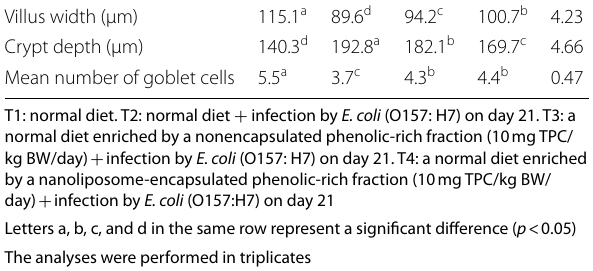
Table 6 The gene expression analysis of mice under different treatments